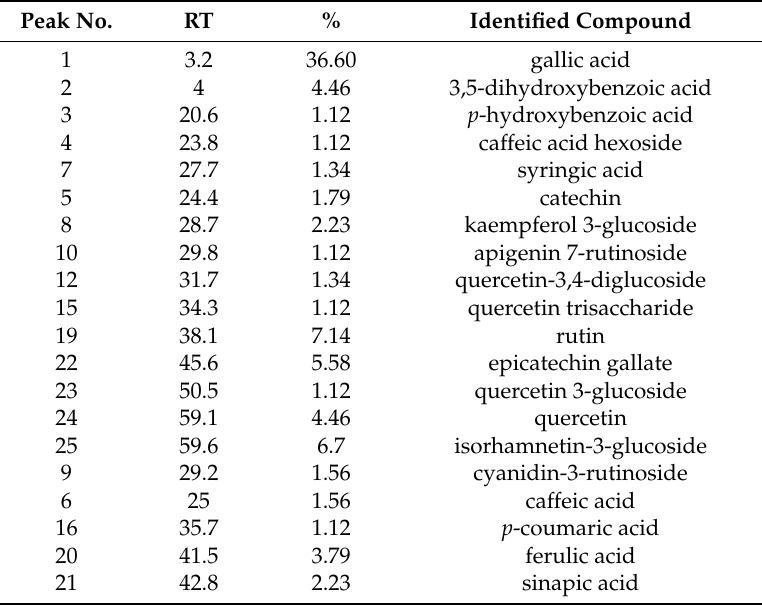
Table 1. Phenolic compounds detected in the aqueous jojoba seed extract by using reversed-phase high-performance liquid chromatography (RP-HPLC). Peak No. RT % Identified